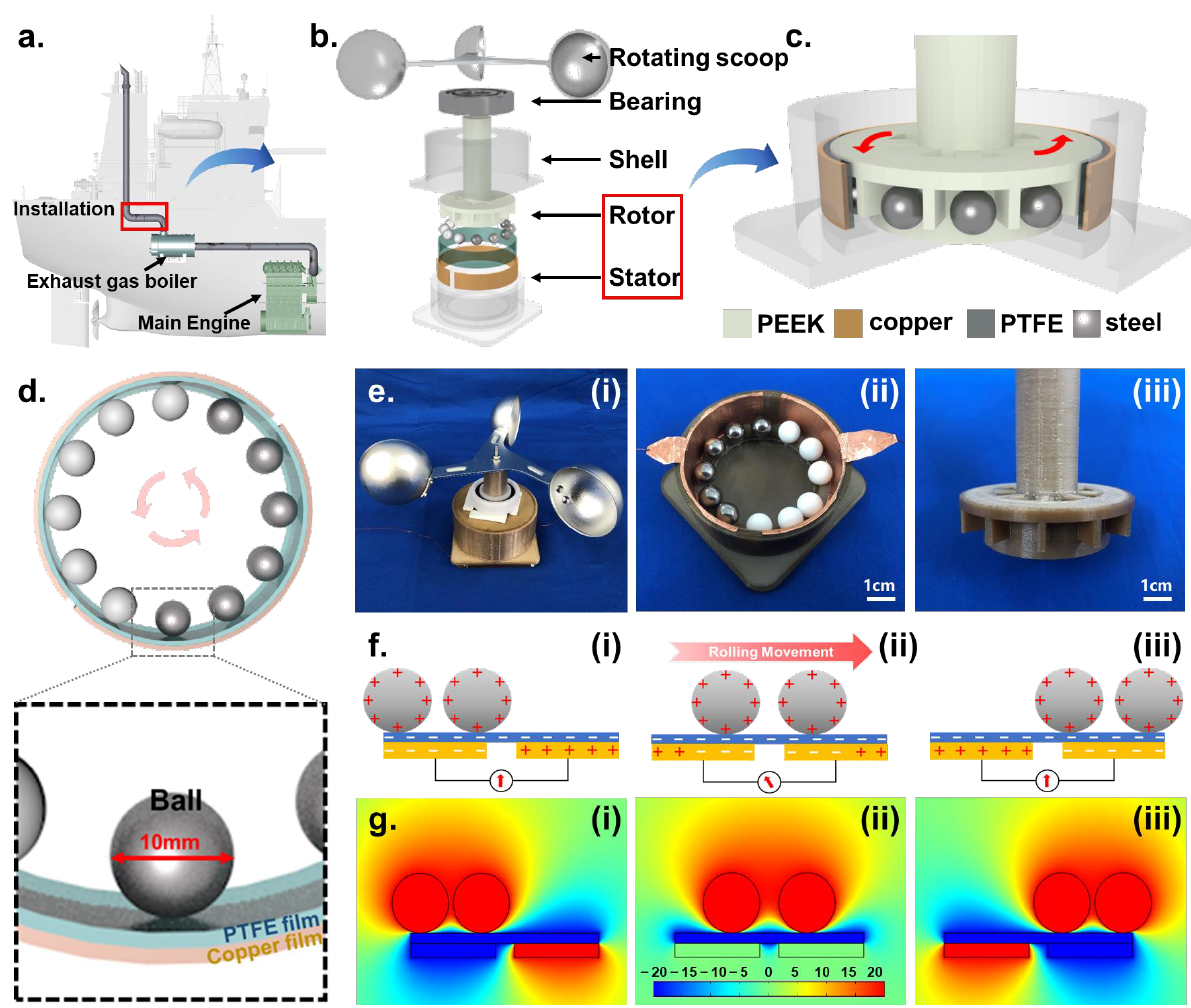
Figure 1. Application scenario, structure, and working principle of the B-TENG. ( a ) Schematic in- stallation of the B-TENG in the exhaust gas system on ship; ( b ) composition of the B-TENG; ( c ) detailed structure of the rotor and stator; ( d ) arrangement of the balls, PTFE film and copper elec- trodes; ( e ) actual image of the ( i ) B-TENG assembly, ( ii ) stator and ( iii ) rotor; ( f ) (i-iii) working prin- ciple of the B-TENG; ( g ) (i-iii) electric potential distribution simulation results of the B-TENG by COMSOL Multiphysics.